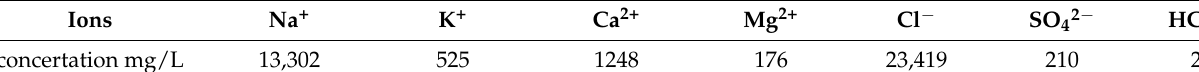
Table 1. The formation water ion concentration.